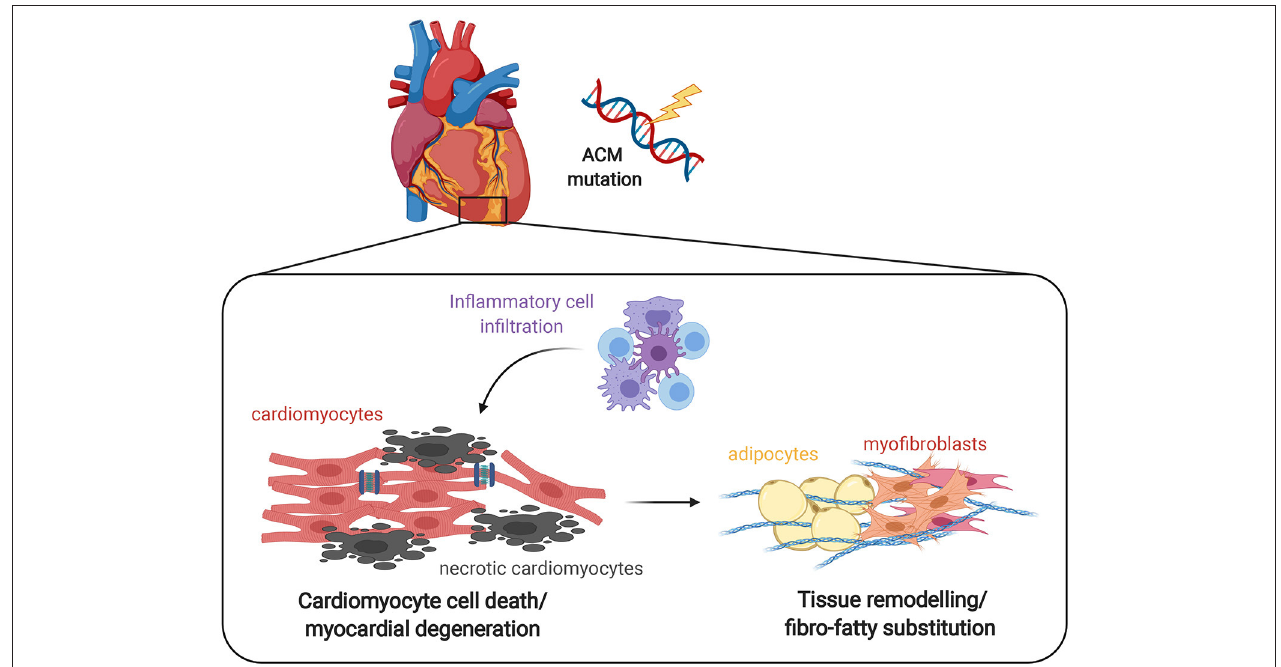
FIGURE 1 | Effect of inflammation on ACM heart. The progressive myocyte death (apoptosis and/or necrosis) and myocardial degeneration due to desmosomal defects leads to the accumulation of inflammatory cell infiltrates, that ultimately results in tissue remodeling by abnormal fibro-adipose deposition as a reparative response to replace loss of cardiomyocytes. It remains to be clarified whether the inflammatory process is the first event that determines the death of cardiomyocytes and the consequent repair process or rather is a reactive